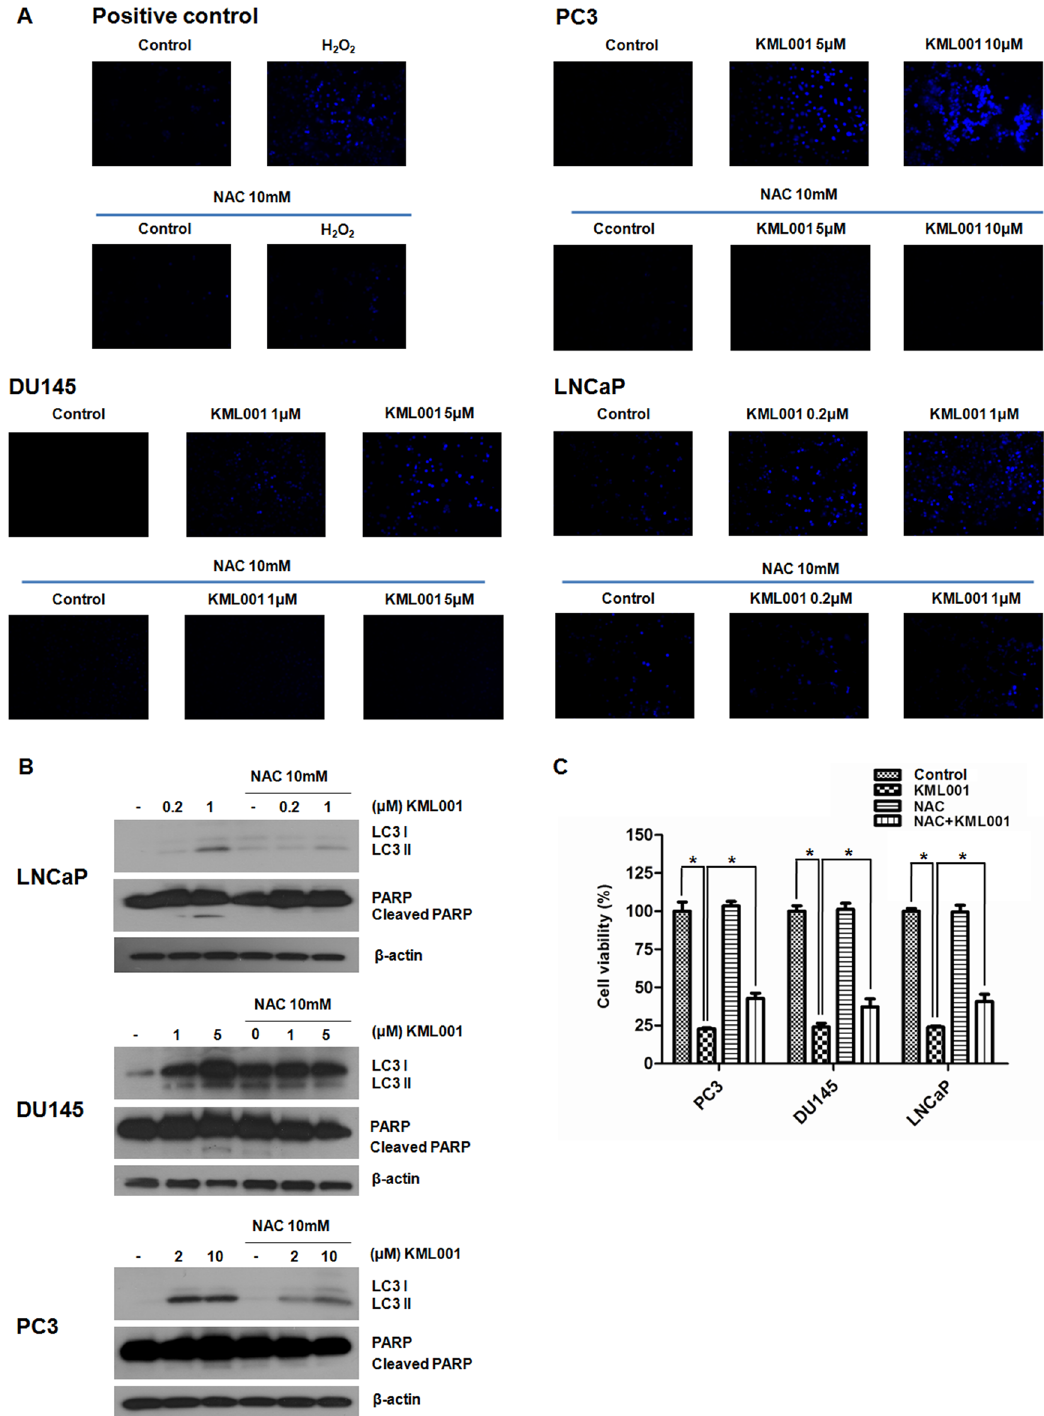
Fig 5. Regulation of autophagy and apoptosis by ROS. All 3 prostate cancer cells were treated with the indicated concentration of KML001 in the absence or presence of 5 mM NAC for 24 h. (A) KML001 induces dose-dependent ROS (blue) accumulation. Cells were stained with DCFH-DA and washed with PBS. More than three fields in each cell were observed by fluorescence microscope (200×), and representative images are shown. (B) NAC inhibition of KML001-induced conversion of LC and caspase activation in prostate cancer cells. (C) Cells were exposed to 10 μ M (PC3), 5 μ M (DU145), or 2 μ M (LNCaP) KML001 in the presence or absence of 1 mM NAC for 72 h. Results were expressed as means ± SD of three independent experiments. * p < 0.05 by one- way ANOVA.